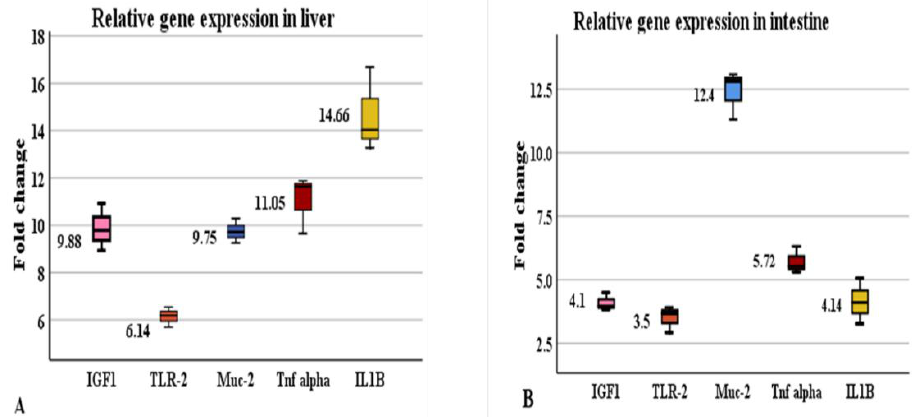
Figure 5. Relative expression of IGF1 , TLR-2 , Muc-2 , TNF alpha and IL-1 β . ( A ) gene expression of liver samples of Hilyses- treated fish (H): IGF1 ( p = 0.019), TLR-2 ( p = 0.010), Muc-2 ( p = 0.008), TNF alpha ( p = 0.016), and IL-1 β ( p = 0.034) are up-regulated ( p < 0.05) in comparison to control group (C); ( B ) gene expression of intestinal samples of Hilyses-treated fish (H): IGF1 ( p = 0.015), TLR-2 ( p = 0.011), MUC-2 ( p = 0.040), TNF alpha ( p = 0.019), and IL-1 β ( p = 0.010) are up-regulated ( p < 0.05) in comparison to control group (C). Data are represented as means ± S.E. ( n =